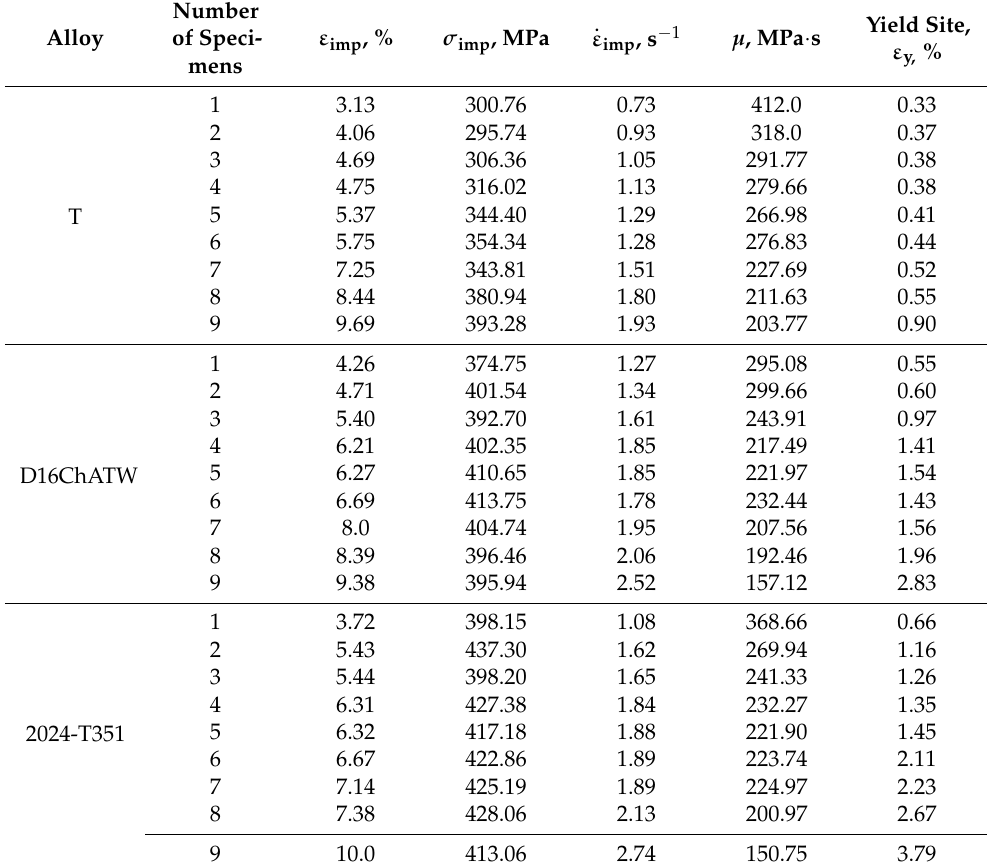
Table 3. The main mechanical parameters that characterize the DNP process and the corresponding lengths of the yield sites that occur in the alloys